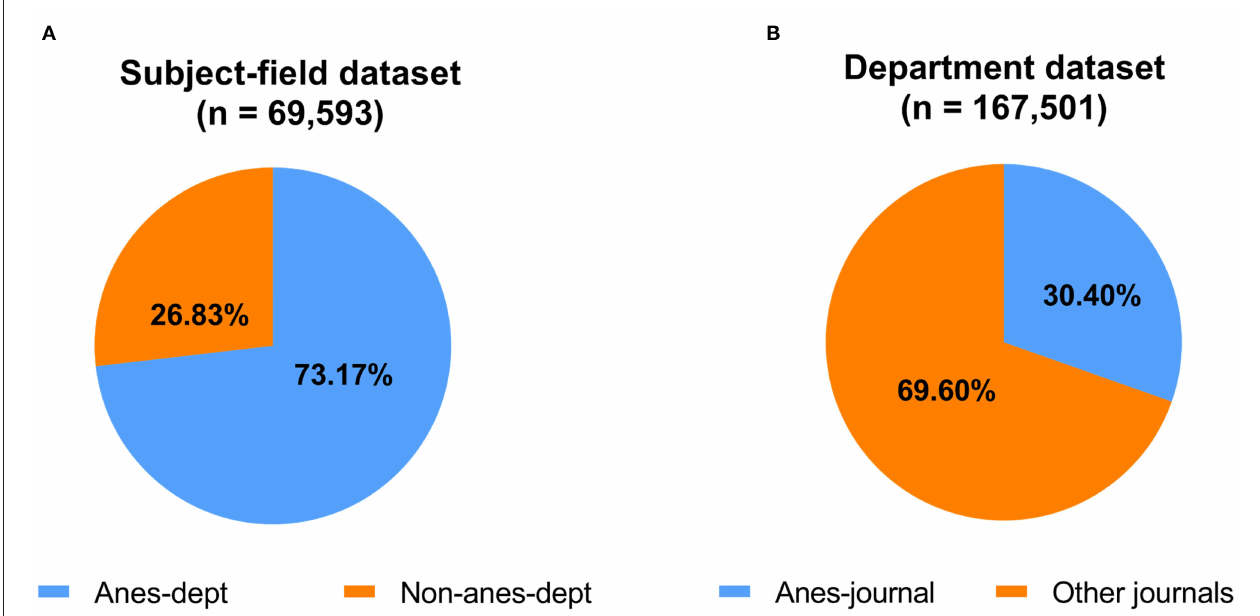
FIGURE 3 | Percentage distribution of articles. (A) Authors of articles in the subject-field dataset from anesthesia departments (anes-dept) and non-anesthesia departments (non-anes-dept) from 1999 to 2018. The size of the circles represents the total number ( n ) of published articles. (B) Fields of publication in the department dataset from 1999 to 2018. The size of the circles represents the total number ( n ) of published articles from anesthesiology journals (anes-journals) and other